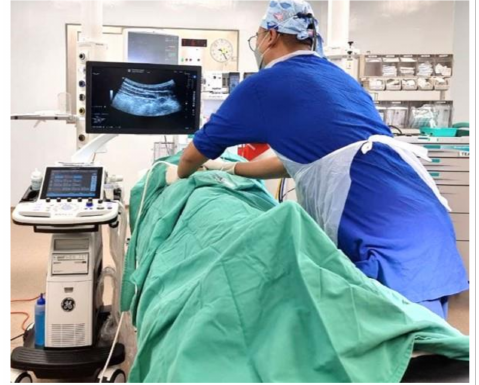
Figure 4. Improper posture: arm abduction more than 30 ◦ , overreaching, trunk rotation while standing from the opposite side during a transversus abdominis plane (TAP) block. Neck flexion, extension, protraction and rotation leading to prolapsed intervertebral discs of the cervical spine and neck muscle tension can be minimised by putting the ultrasound monitor straight in front of the operator with a slight 15 ◦ to 20 ◦ neck flexion while viewing the monitor [29] (Figure 5a,b). Vertically adjustable articulating monitors would be helpful to achieve the ideal position for the